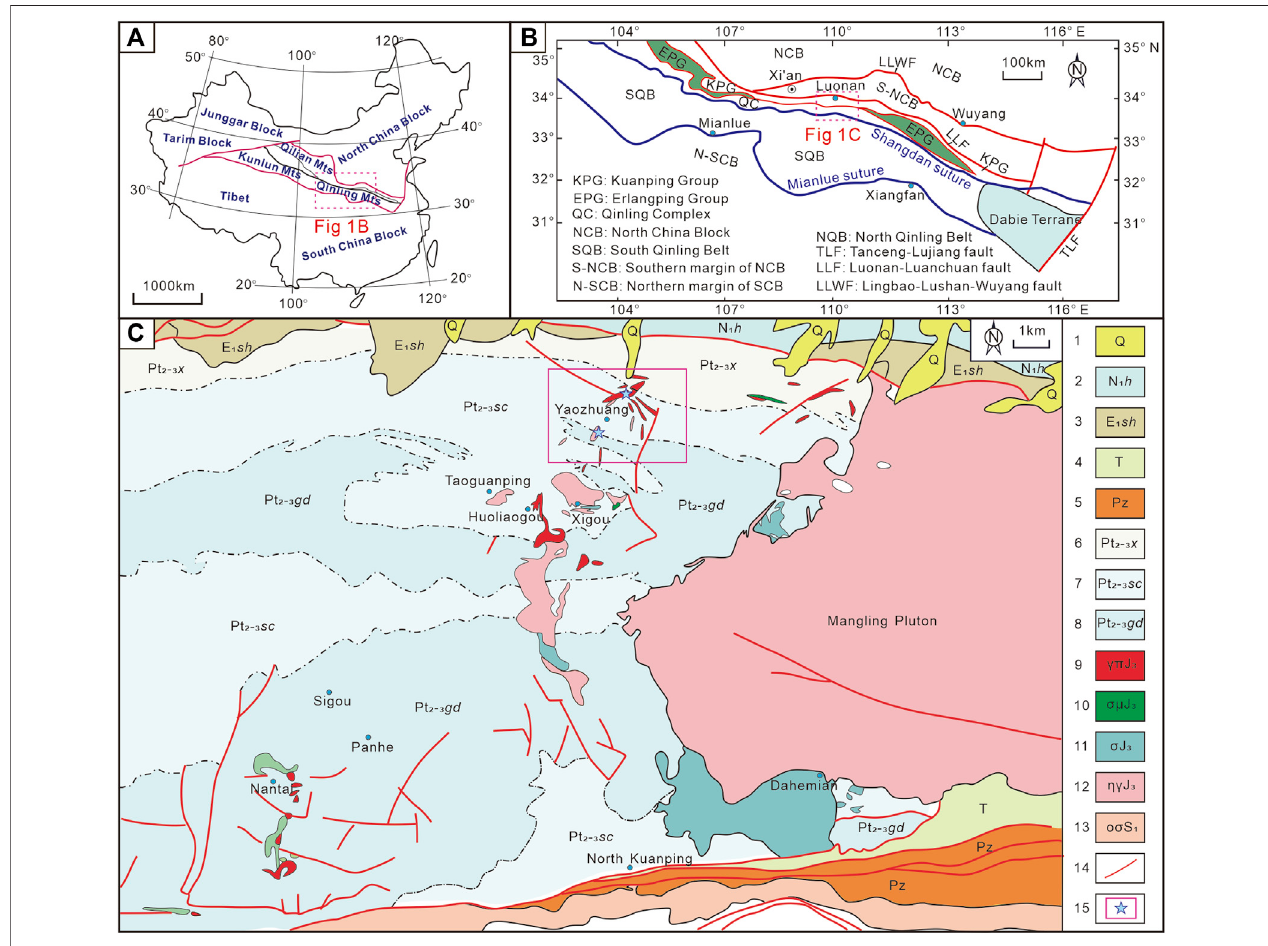
FIGURE 1 | Regional geological map of the western Mangling ore fi eld [ (A) revised after Ke et al., 2012a; (B) after Dong et al., 2011b].